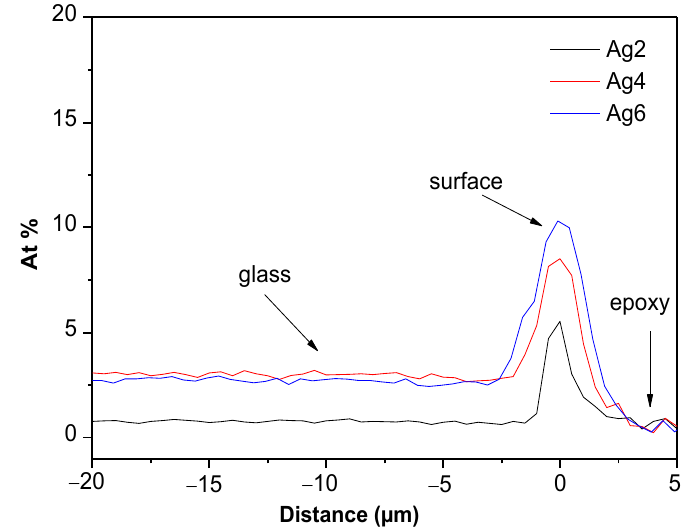
Figure 7. Ag concentration profile measured from the surface of the heat-treated glasses.